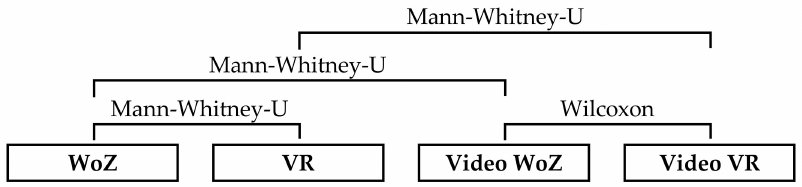
Figure 8. Comparison for the subjective